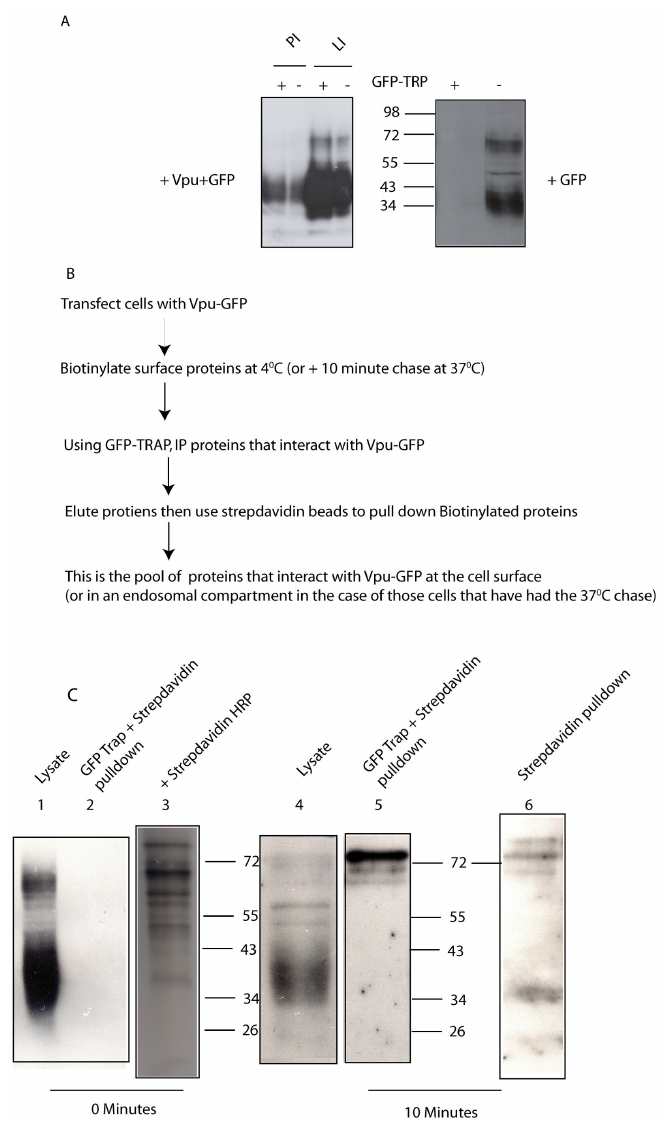
Figure 1. Tetherin interacts with Vpu in whole cells, but does not do so at the cell surface. A . Immunoblot of tetherin in whole cell lysates from HeLa cells transfected to express Vpu-GFP (left panel) or GFP alone (right panel) and incubated in